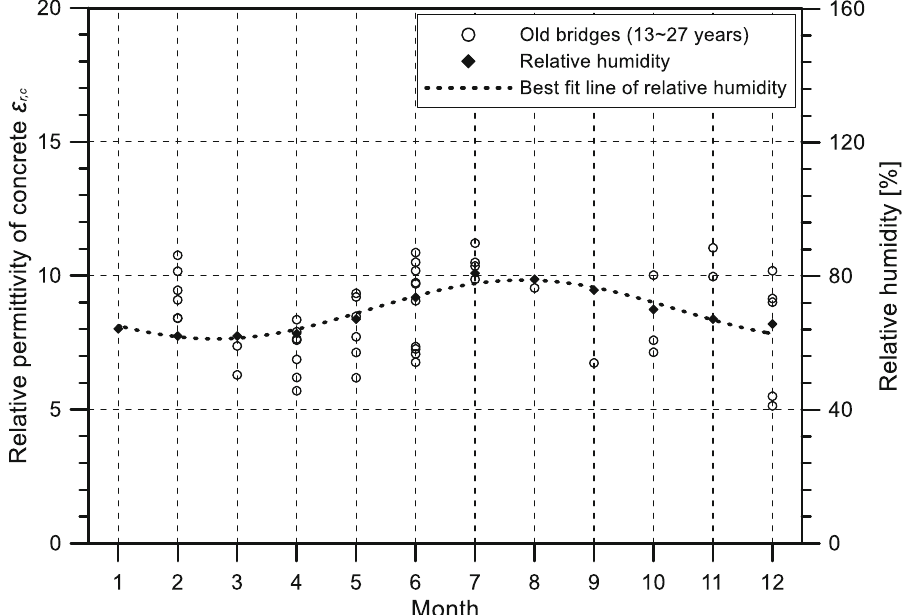
Fig. 5 Variation of relative permittivity of concrete by month, and the variation in the relative humidity of the air by month.